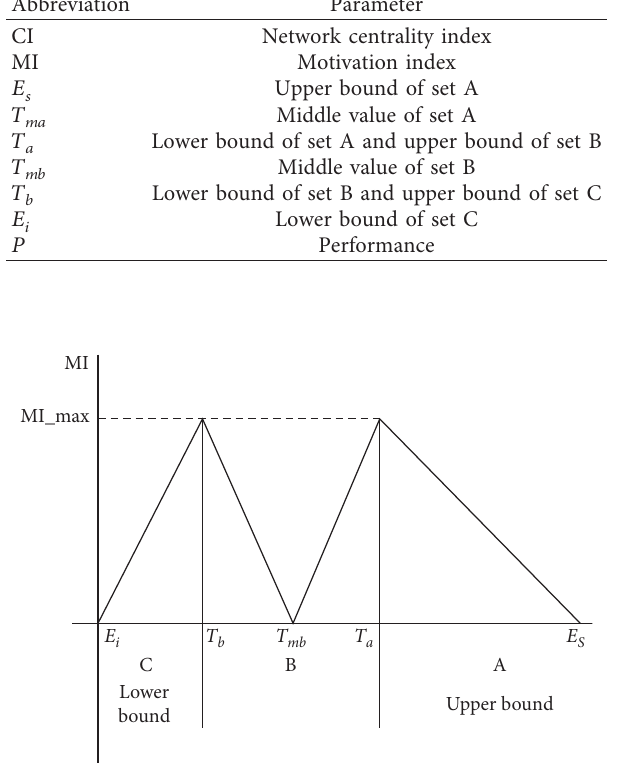
Figure 2: Motivation